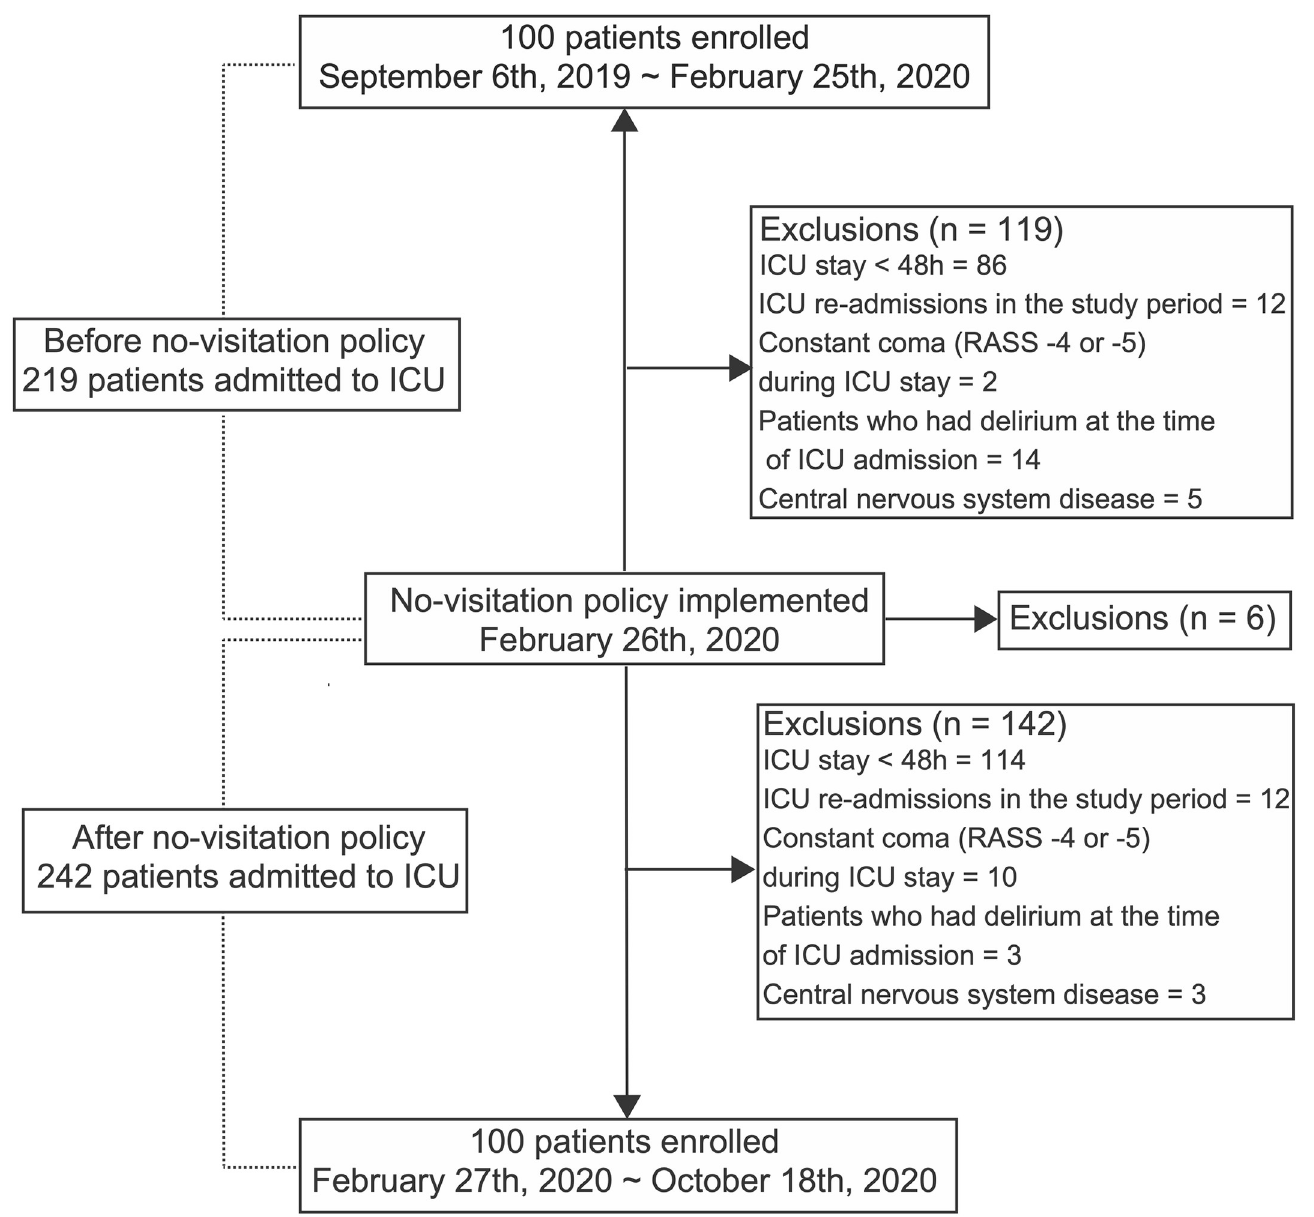
Fig 2. Patient recruitment